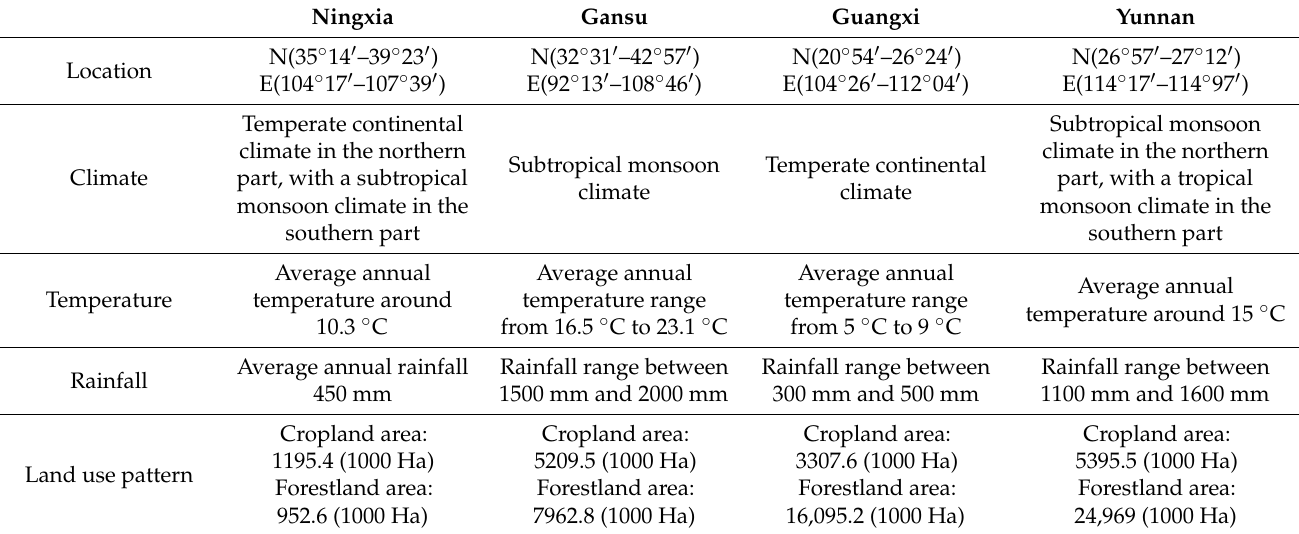
Table 1. The geographical characteristics of study